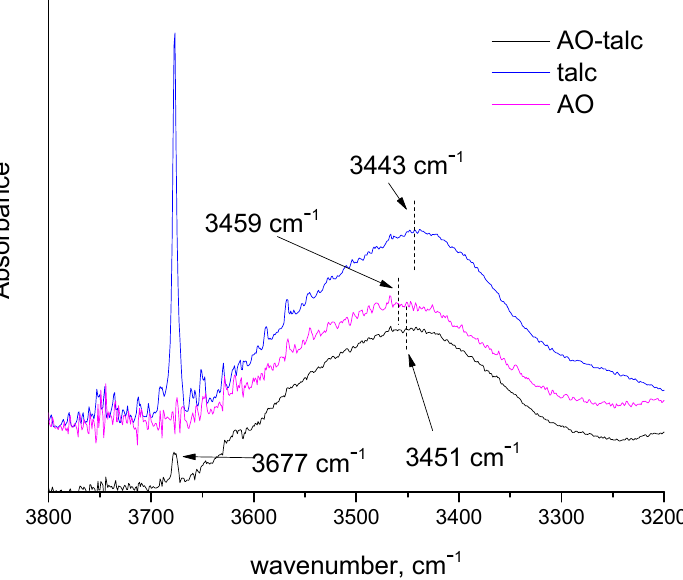
Figure 6. FTIR spectra of talc, of the masterbatch of the antioxidant (AO) and their composite material (AO-talc) in the region 3200–3800 cm − 1 .